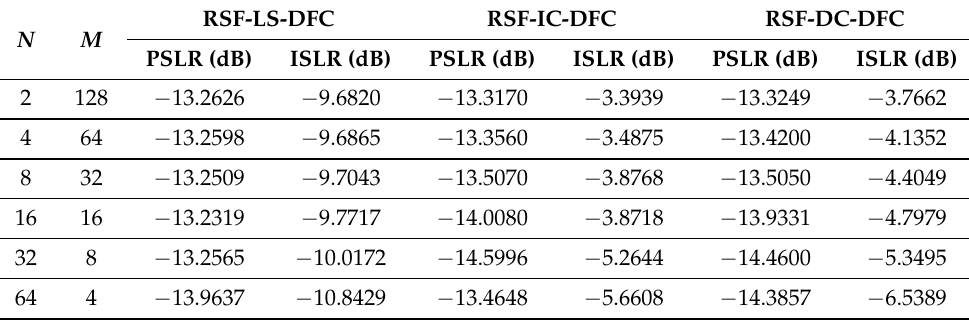
Table 1. Comparison of the AF sidelobe performance with different N and M.